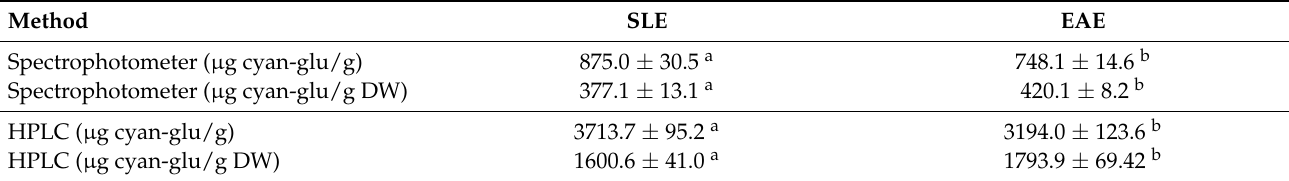
Table 4. Comparison of total monomeric anthocyanin content of water-soluble fractions of bilberry pomace as measured spectrophotometrically by the pH differential method and